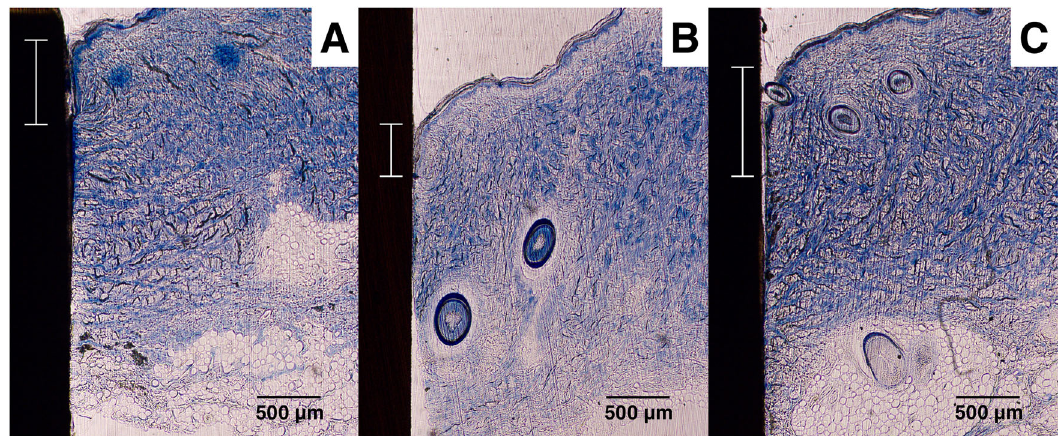
Fig. 14 Examples of histology slides of the PEEK surfaces: A Unmodi fi ed PEEK, B PEEK + HA, C PEEK + ZrP. The Epidermal downgrowth (shown with scale bar) for these samples were A 0.68, B 0.43, C 0.89 mm